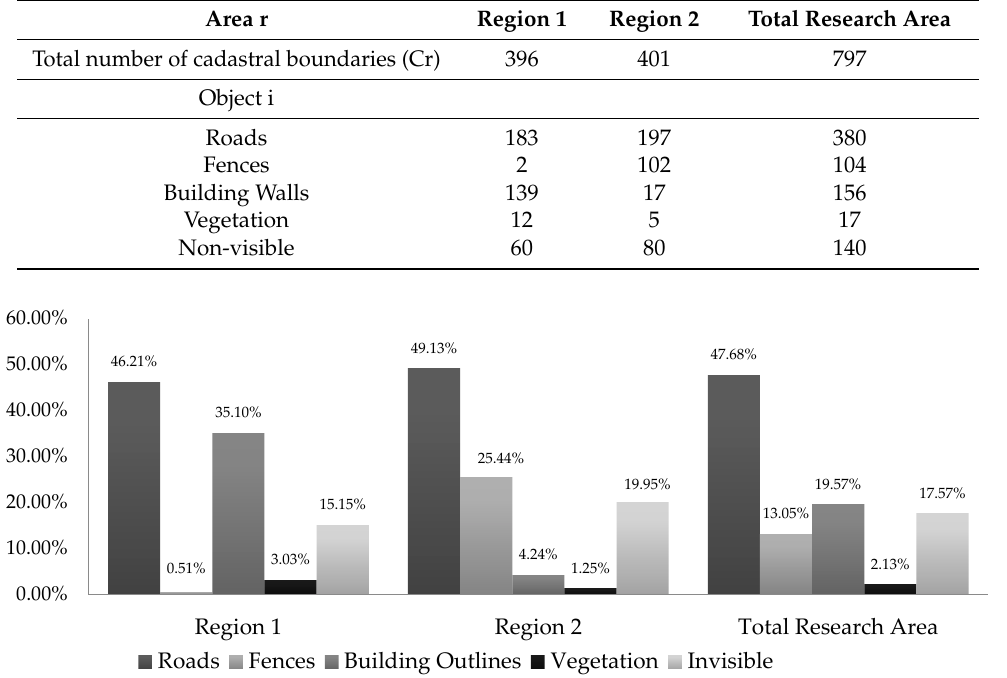
Figure 5. Proportion of cadastral boundaries coinciding with physical object.